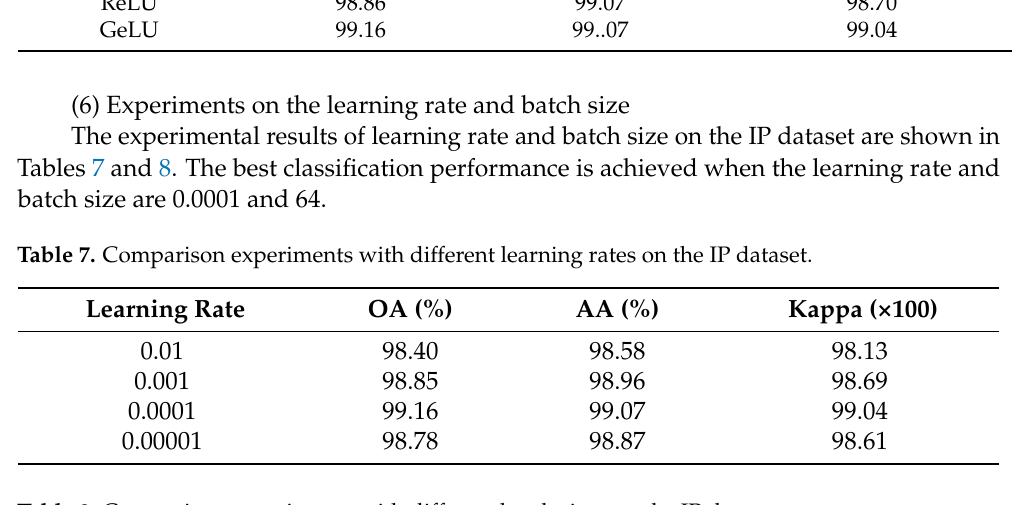
Table 8. Comparison experiments with different batch sizes on the IP dataset.